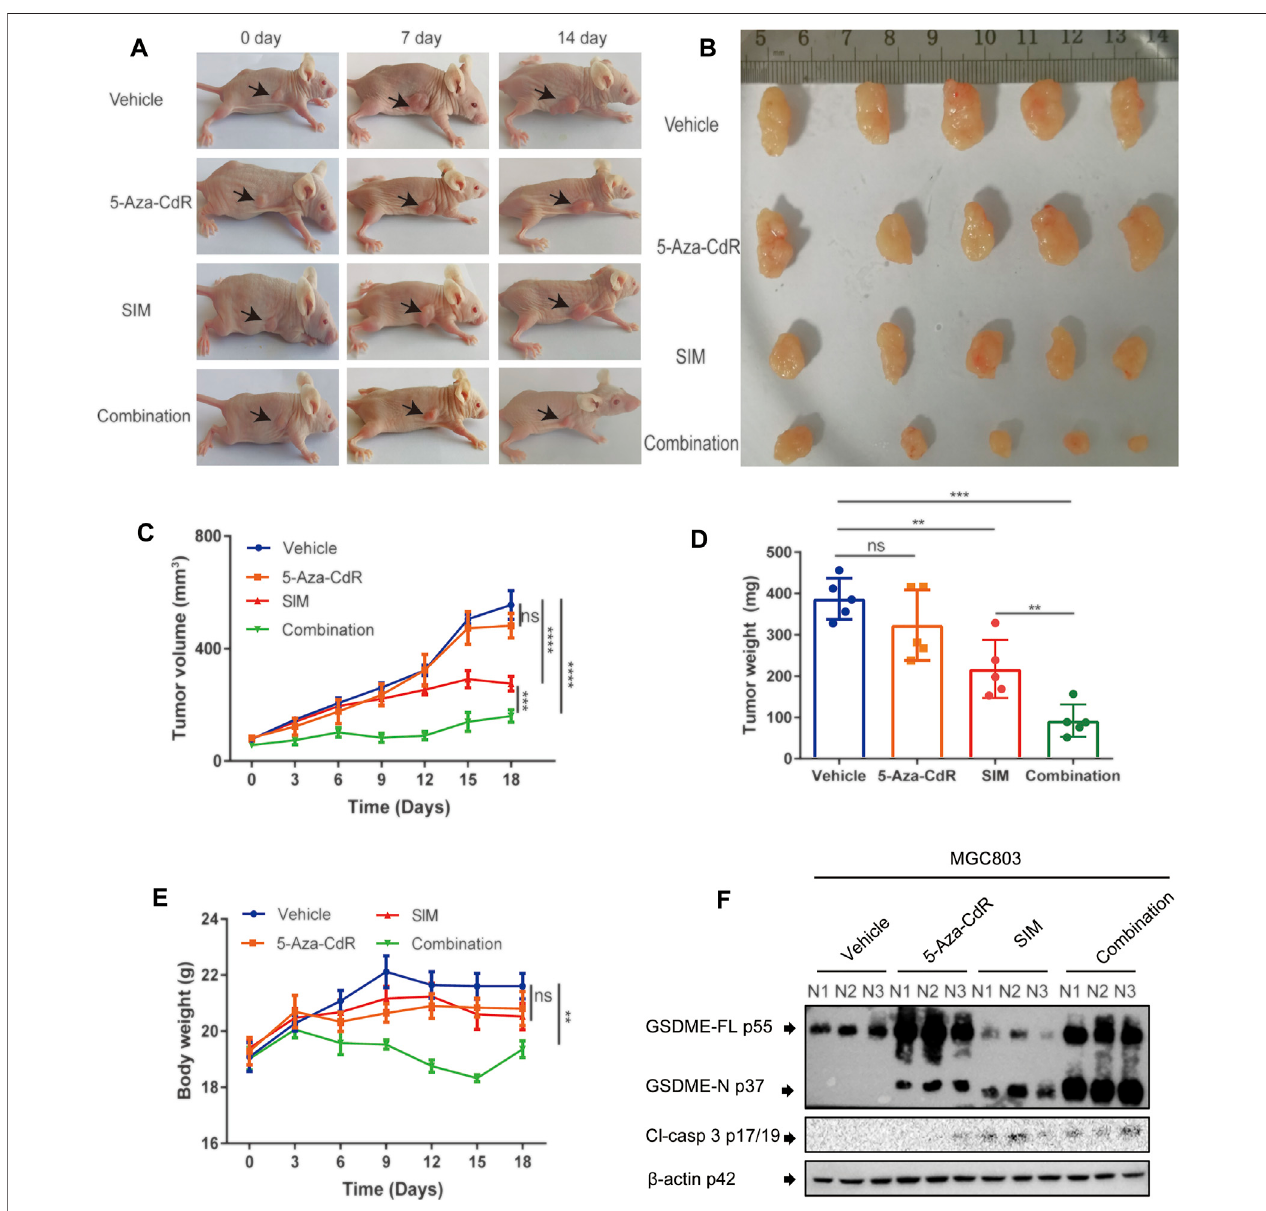
FIGURE 7 | Combination of SIM and 5-Aza-CdR potently inhibits tumour growth in vivo . (A) Photos of mice with xenograft tumours during the treatment. (B) Tumours dissected at the end point of the experiment. (C) Tumour volumes during the treatment ( n = 5). (D) Tumour weights at the end of the experiment ( n = 5). (E) Average body weight of each group during the treatment ( n = 5). (F) Protein cleavage of GSDME and caspase-3 in tumour tissues, detected by Western blotting ( n = 3). Dataareshownasmean±SDorrepresentativesofatleastthreeindependentexperiments. β -actinwasusedasaninternalcontrolforWesternblot. pppp p < 0.0001 and p > 0.05 not signi fi cant